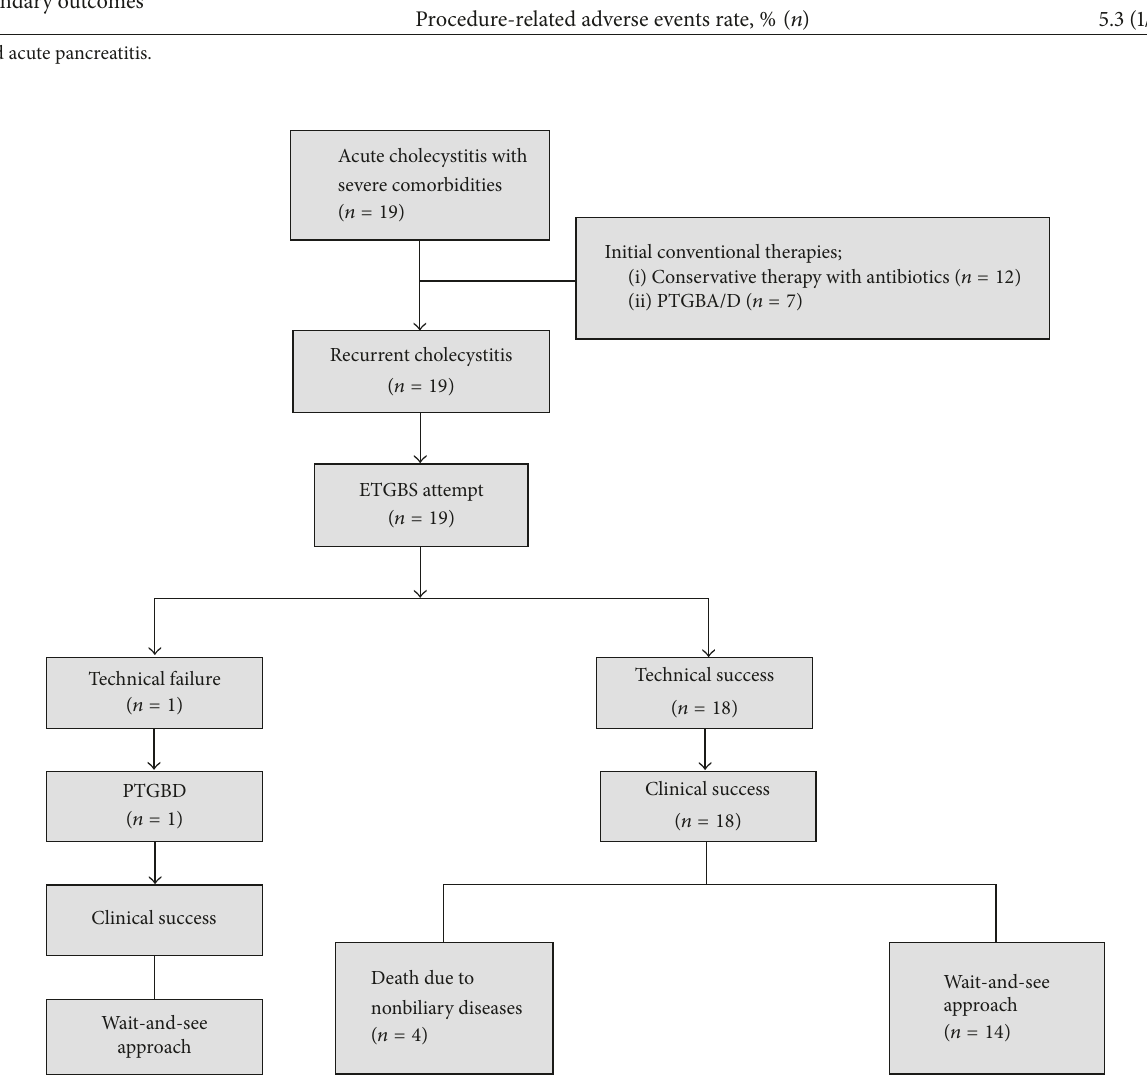
Figure 3: Flow diagram of patient’s clinical